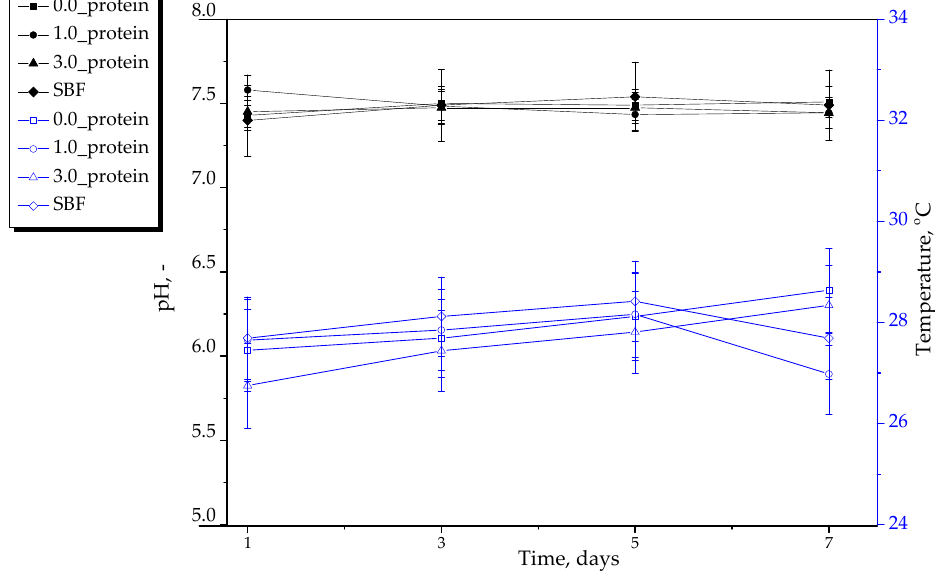
Figure 6. Results of hydrogels’ incubation in SBF ( n —number of repetitions, n = 3).